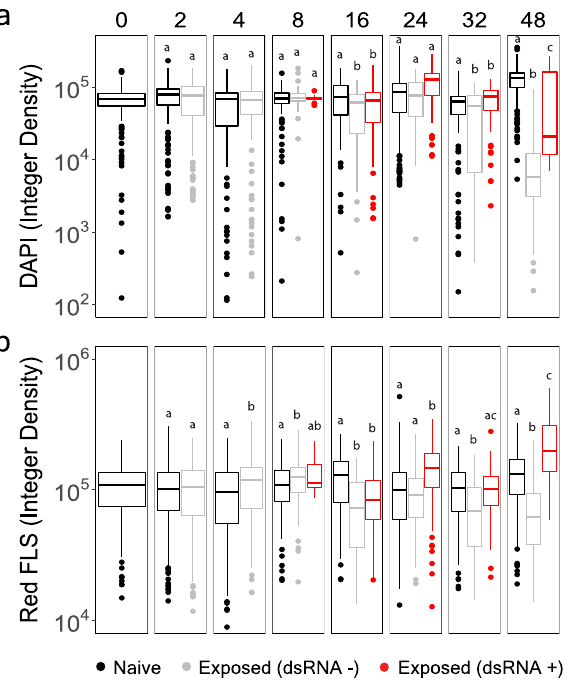
Figure 5. Assessment of chromosomal integrity ( a ) and photosynthetic fluorescence ( b ) between different Heterocapsa populations defined by treatment and dsRNA status as interpreted from Fig. 4 data (described in Table 1). Naive cultures are represented in black. HcRNAV-exposed cells that are not associated with dsRNA production are grey, while HcRNAV-exposed cells that significantly produce dsRNA are red. The integer density represents cells normalized by size to account for different cross-sectional planes that might be represented in thin sections. Lower-case letters above each box plot indicate significance groups within each facet, and were determined using Welch’s two-tailed t-test (p-value < 0.05). The data are displayed using the geom_boxplot() function in ggplot2 under the default settings for the box to denote data distribution quartiles, whiskers, and